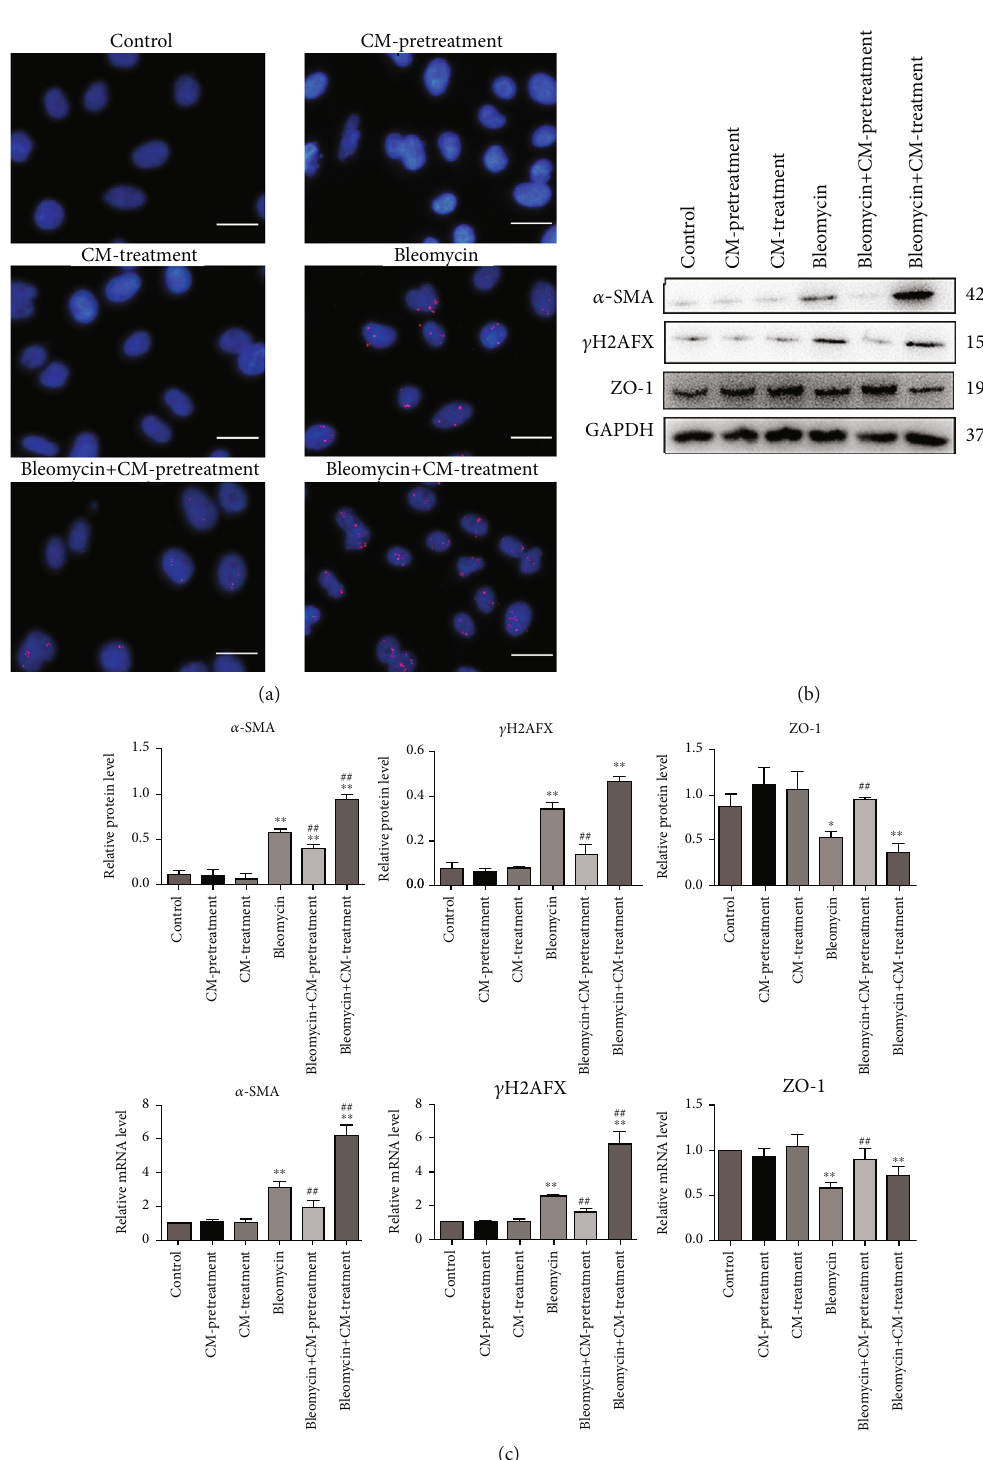
Figure 3: Preventive administration of HUCMSCs can e ff ectively attenuate pulmonary fi brosis induced by bleomycin in A549 cells. (a) Results of immuno fl uorescence staining in A549 cells of the control, CM-pretreatment, CM-treatment, belomycin, belomycin+CM- pretreatment, and belomycin+CM-treatment groups. TP53BP1 are stained in A549 cells with antibodies (red). Nuclei are stained with DAPI (blue). Scale bar = 100 μ m. (b) Results of western blot in the same groups. (c) Results of qPCR in the same groups. Data are presented as mean ± SEM . ∗ p ≤ 0 : 05 , ∗∗ p ≤ 0 : 01 vs. the control; # p ≤ 0 : 05 , ## p ≤ 0 : 01 vs. the